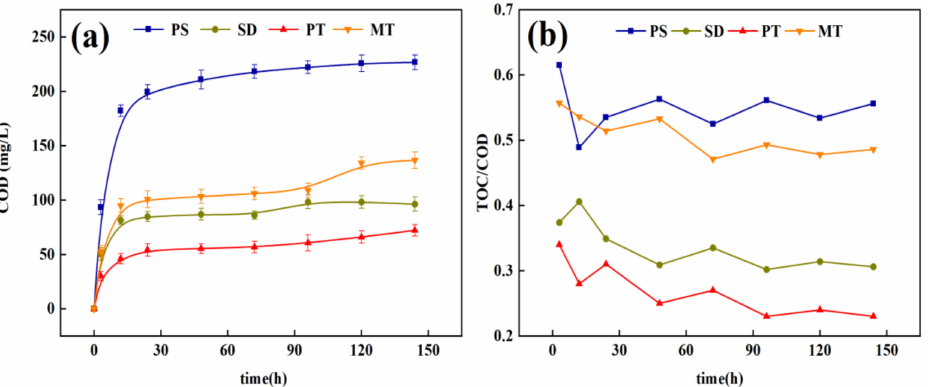
Figure 2. Carbon release curves and TOC/COD of different carbon sources: ( a ) Carbon release curves of different carbon sources; ( b ) TOC/COD of different carbon sources. Note: TOC: total organic carbon; COD: chemical oxygen